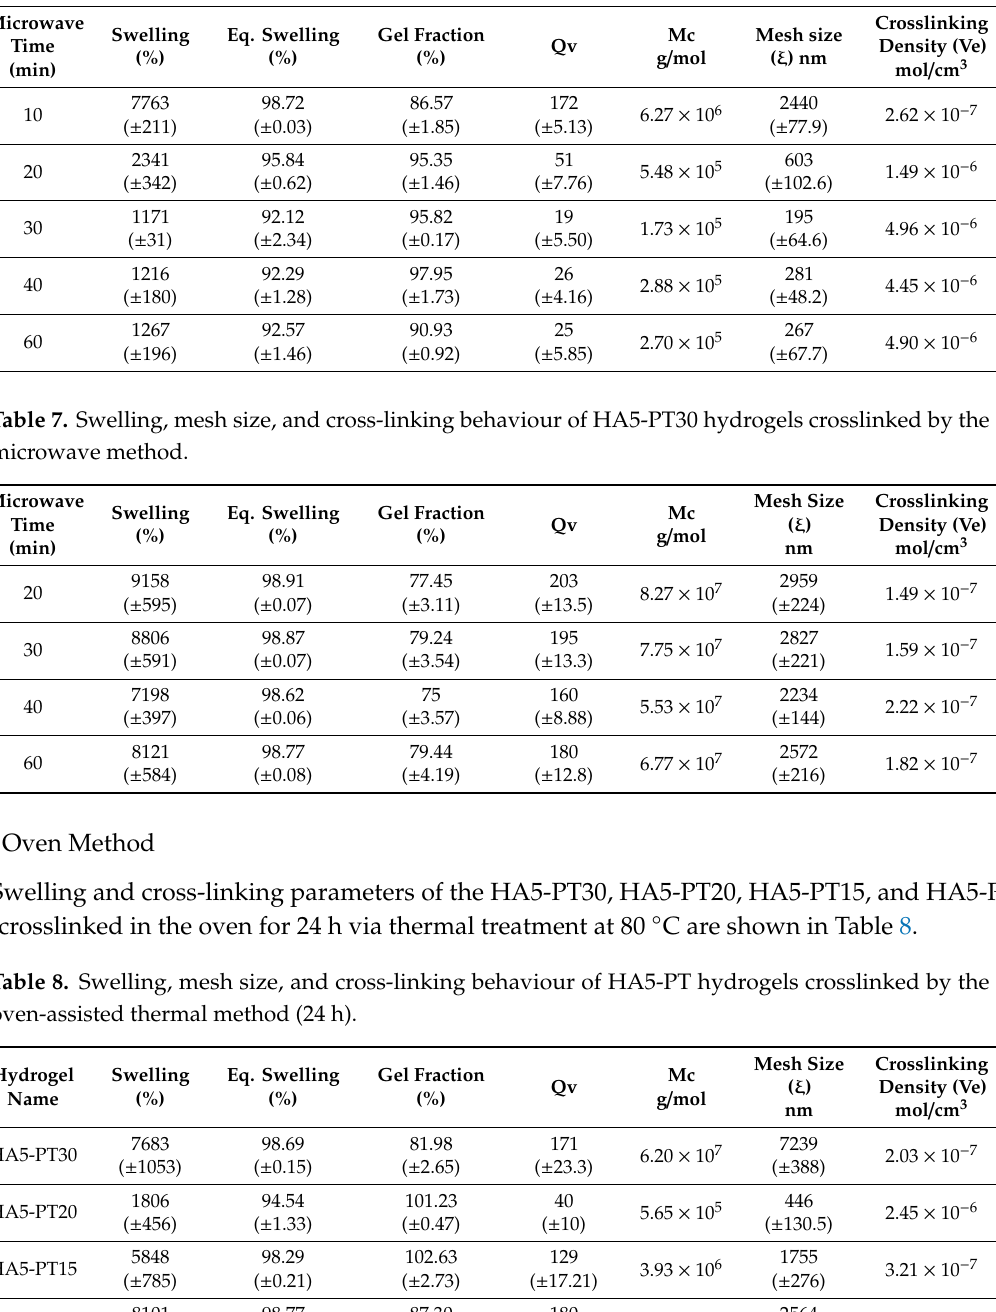
Table 6. Swelling, mesh size, and cross-linking behaviour of HA5-PT20 films crosslinked by the microwave method.